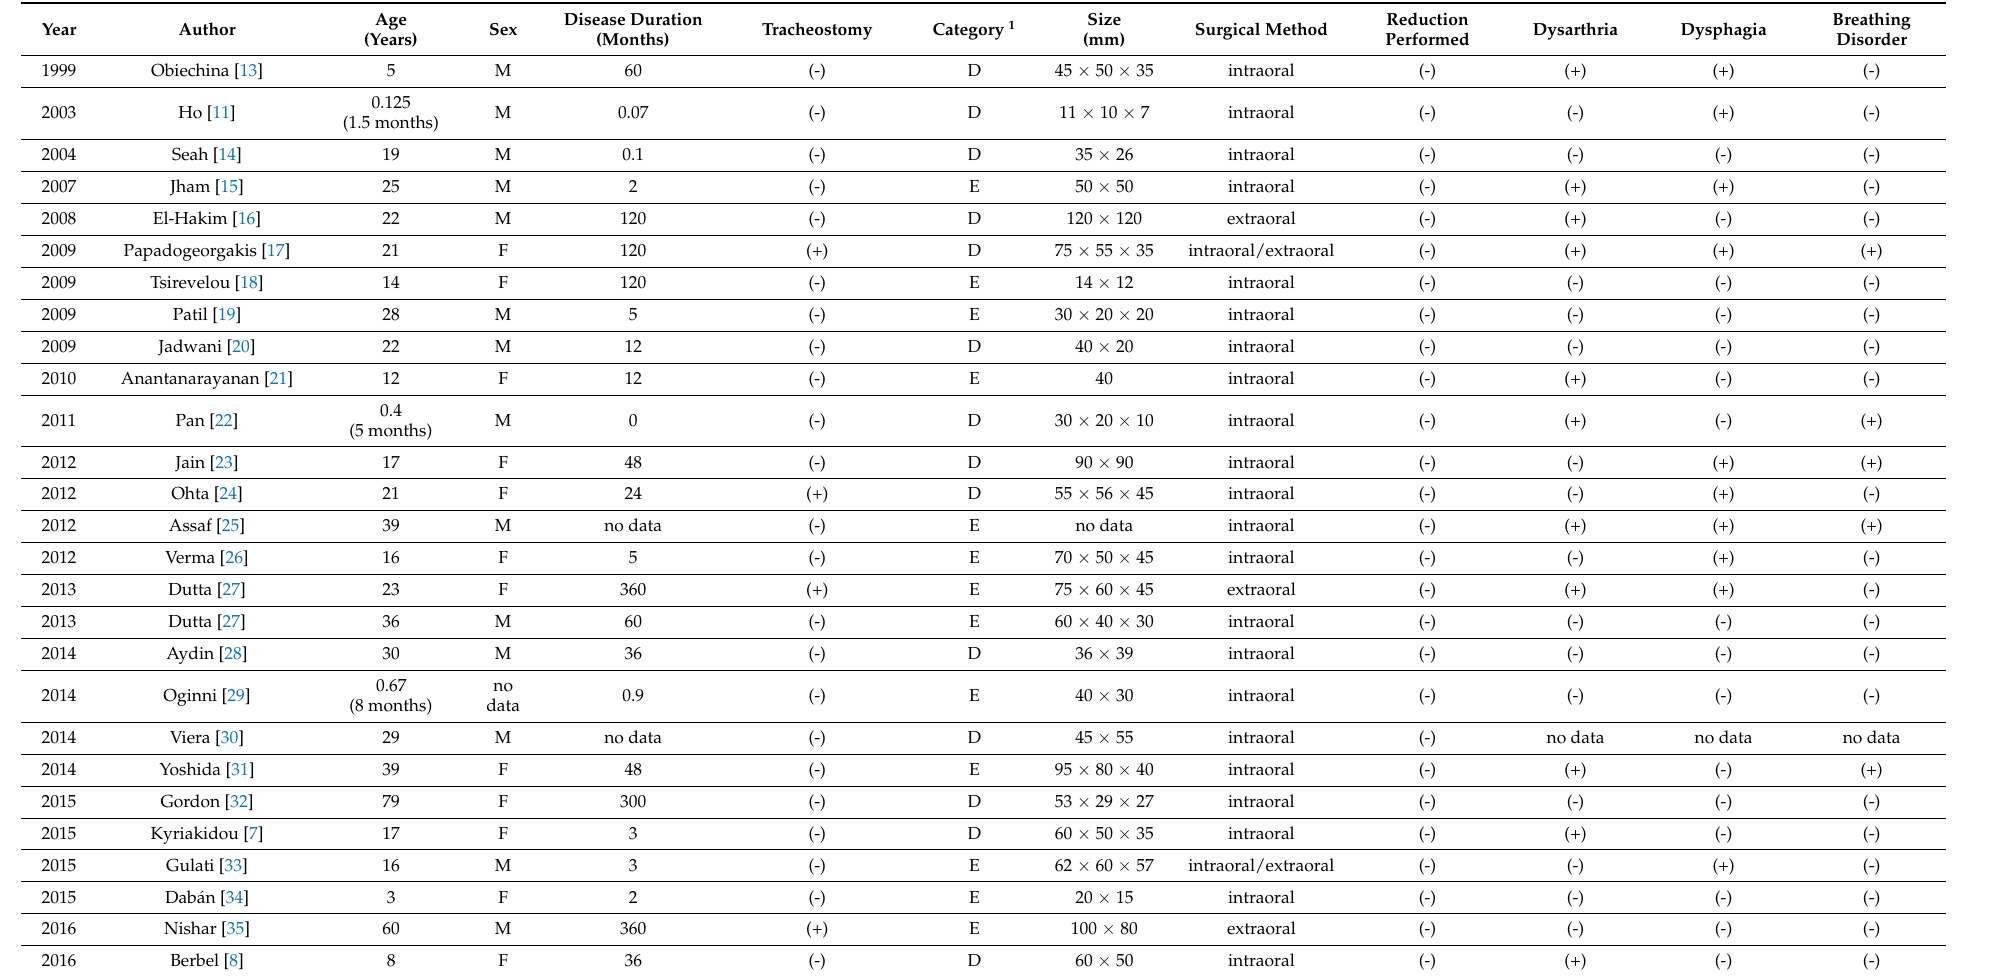
Table 1. List of cases: oral dermoid and epidermoid